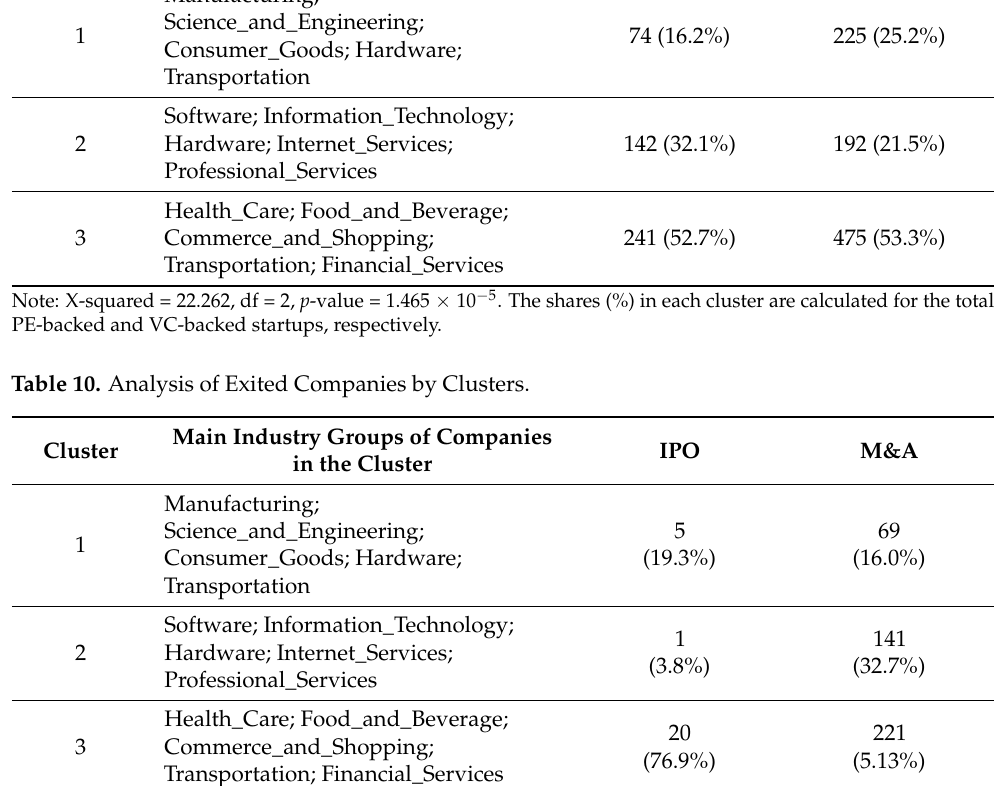
Table 9. Later Stage Companies by Cluster and Exit Status. Cluster